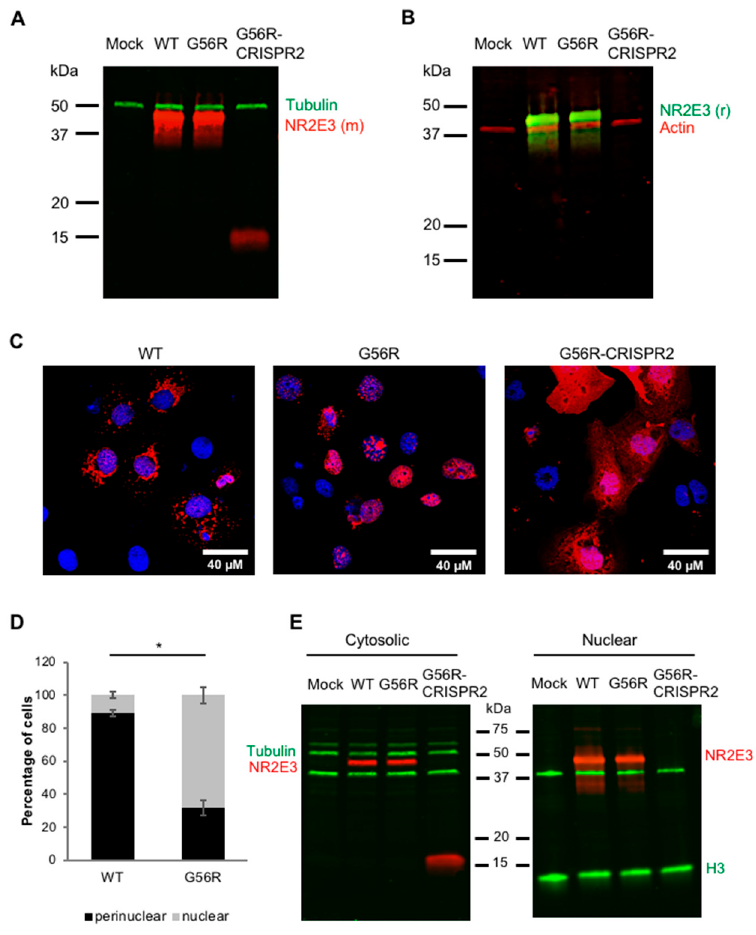
Figure 5. Effect of mutant allele knockout on NR2E3 expression. Western blot analysis of HEK293 cells mock-transfected or transfected with the pCDNA3 constructs expressing WT, G56R or G56R- CRISPR2 NR2E3 and hybridized with ( A ) a mouse monoclonal anti-NR2E3 antibody (NR2E3 (m); in red) or ( B ) a rabbit polyclonal NR2E3 antibody (NR2E3 (r); in green). Both anti-NR2E3 antibodies detected a 45-kDa protein in WT and G56R-expressing cells. The mouse monoclonal anti-NR2E3 antibody detected a truncated 16-kDa protein in the G56R-CRISPR2-expressing cells ( A ). Loading controls, an anti-tubulin antibody detected a 55-kDa protein (in green) ( A ); an anti-actin antibody detected a 42-kDa protein (in red) ( B ). ( C ) Representative images following IF analysis of COS7 cells transfected with the pcDNA3 constructs expressing wild type (left), G56R (middle) or G56R- CRISPR2 (right) NR2E3 in red; nuclei labelled in blue. ( D ) Quantification of the percentage of COS7 cells transfected with the pCDNA3 constructs expressing wild type or G56R NR2E3 showing the mixed perinuclear and nuclear versus mainly nuclear localization profiles. Results are expressed as mean ± SEM of three independent experiments ( n = 3; * p < 0.05; Mann and Whitney test); each experimental value represented the mean of five separate fields. ( E ) Western blot analysis following differential centrifugation of cytosolic (left) and nuclear (right) fractions of HEK293 cells mock- transfected (lanes 1) or transfected with the pCDNA3 constructs expressing WT (lanes 2), G56R (lanes 3) or G56R-CRISPR2 (lanes 4) NR2E3. Bands corresponding to 45-kDa NR2E3 were detected in both fractions for WT and G56R-transfected cells, whereas a 16-kDa protein was only detected in the cytosolic fraction of G56R-CRISPR2-transfected cells. To control for fraction purity, both of the membranes were hybridized with anti-tubulin (55 kDa; in green) and anti-histone H3 (15 kDa; in green). A non-specific 40-kDa band could be detected after incubation with the H3 antibody on both membranes.